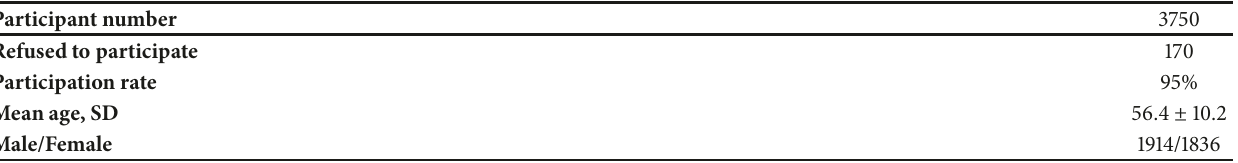
Table 1: Demographic characteristics of participants.